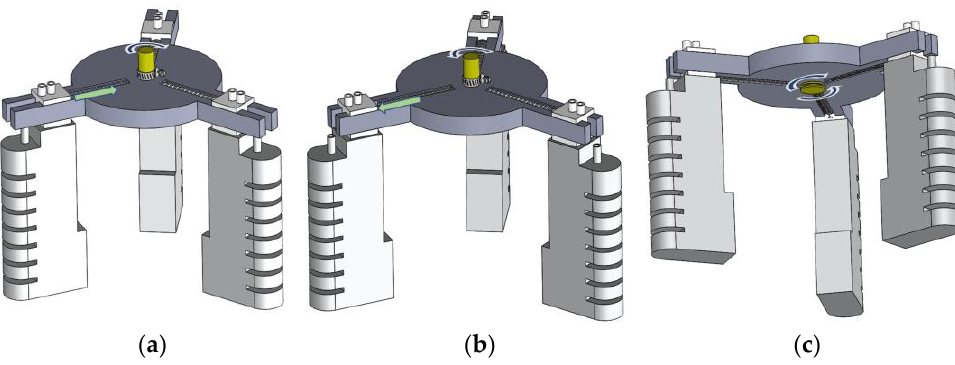
Figure 2. Assembly drawing of the fixture. ( a ) Fixture contraction movement. ( b ) Fixture expansion movement. ( c ) Rope reel rotating rope movement. The rotation arrow represents the direction of rotation of the rope reel, and the straight arrow represents the direction of movement of the part.